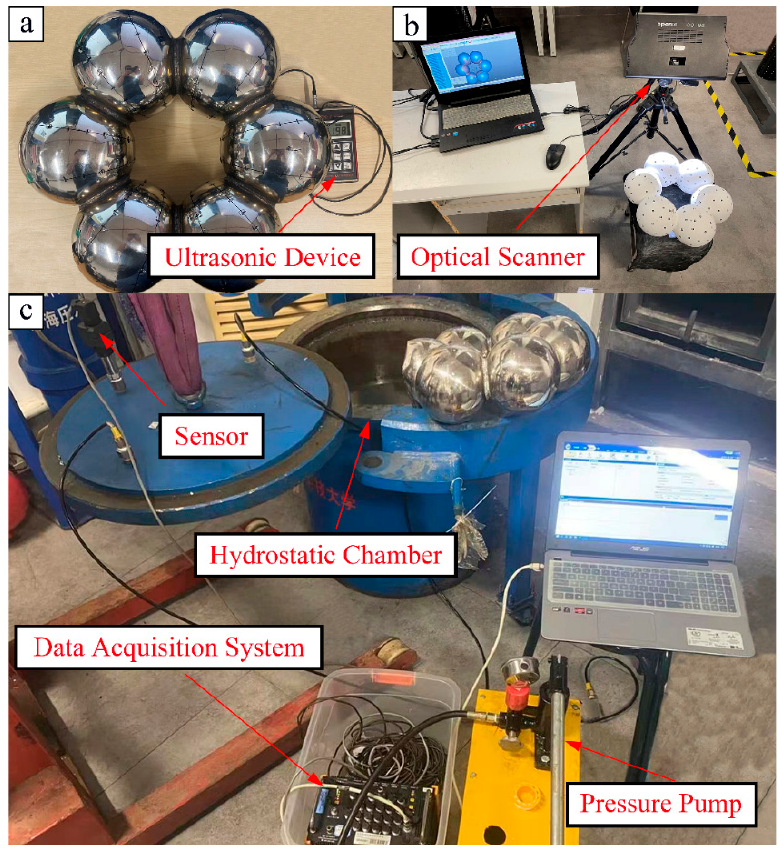
Figure 3. Photographs of ultrasonic measurement scene ( a ), optical scanning scene ( b ), and hydrostatic tests scene ( c ). Table 1. Geometric properties, buckling load, and experiment-derived collapse pressure of ST-1 and ST-2 sphere-segmented toroidal